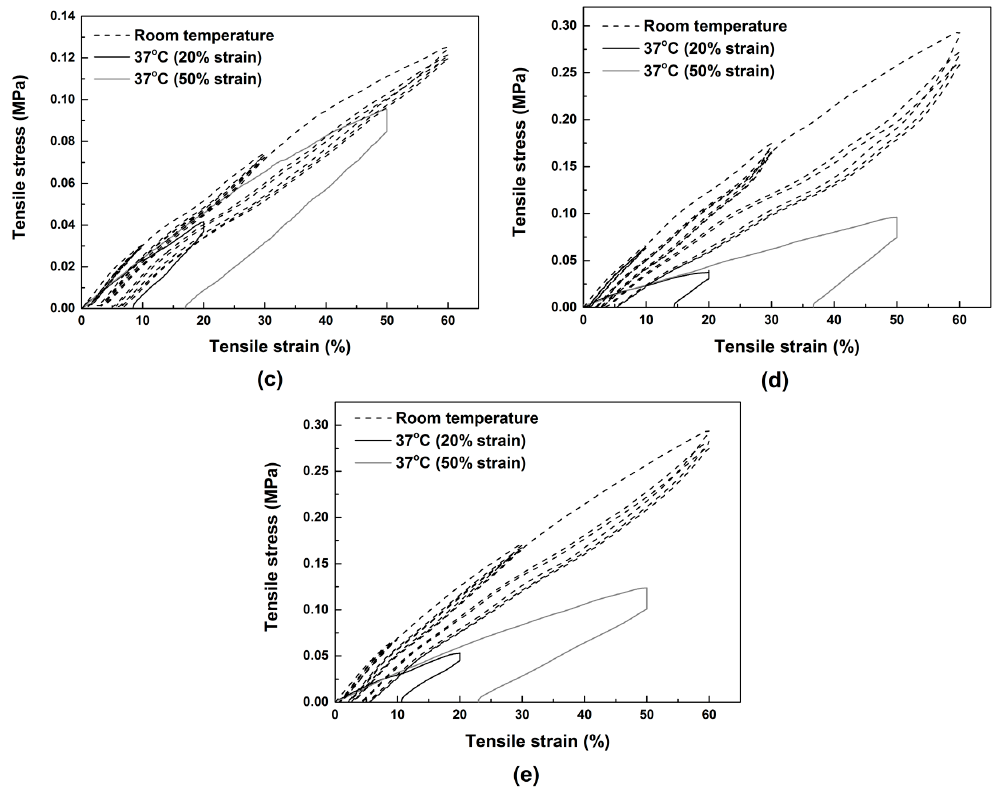
Figure 7. Comparison of the stress vs. strain relationships under uni-axial tension at room temperature and 37 °C (to 20% and 50% strains) in SPPM1 ( a ), SPPM2 ( b ), SPPM3 ( c ), SPPM4 ( d ) and SPPM5 ( e ).